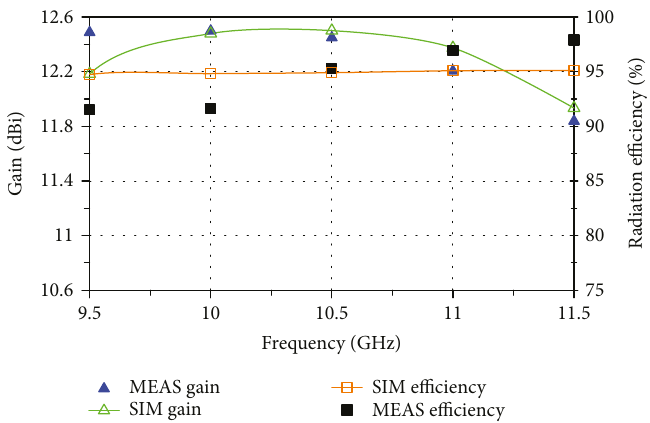
Figure 12: Maximum gain versus frequency of the proposed lens antenna.